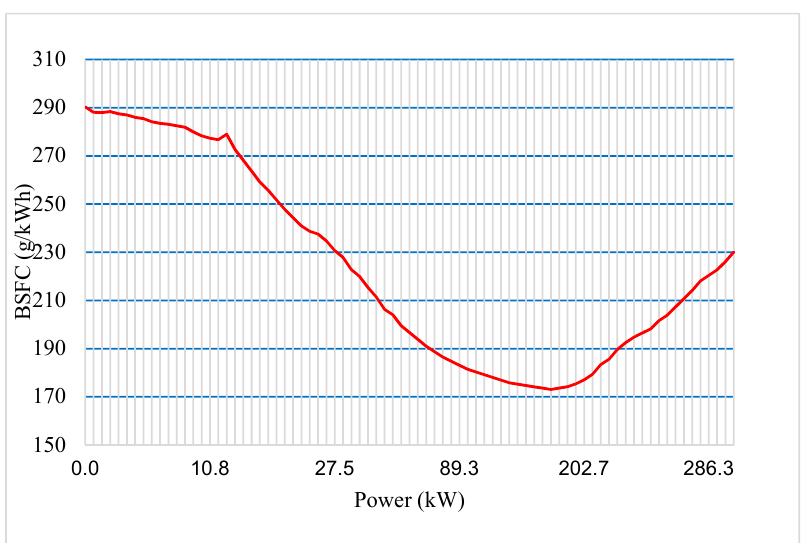
Figure 7. Specific fuel consumption of proposed VSDG